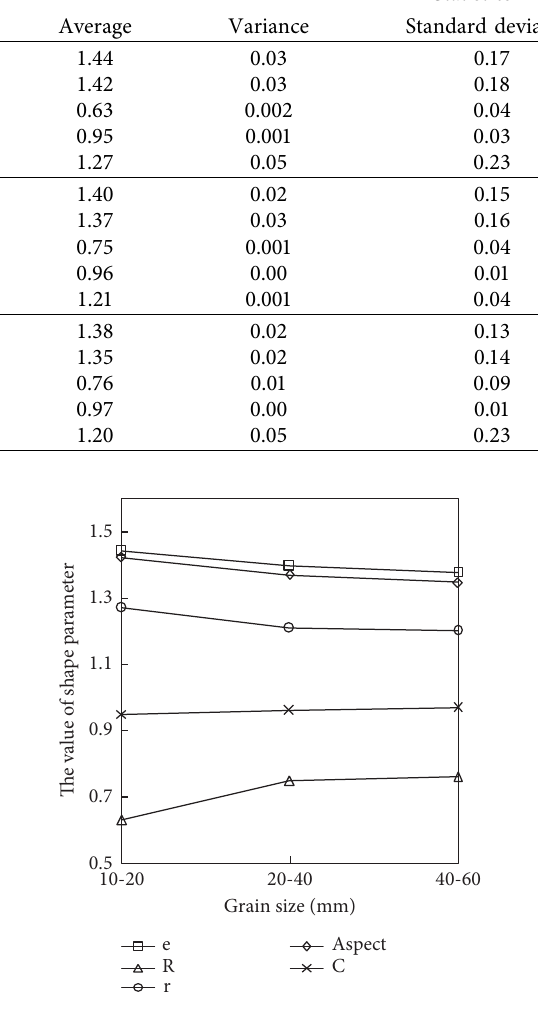
Figure 6: Variation of shape parameters with particle